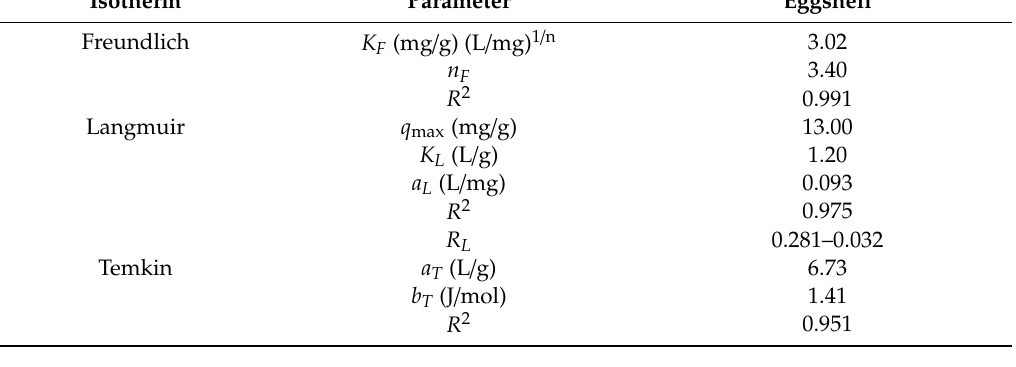
Table 2. The plot of ln q e versus ln C e gave a straight line over the entire concentration range studied in the representation of the Freundlich isotherm, as may be observed in Figure 5a.